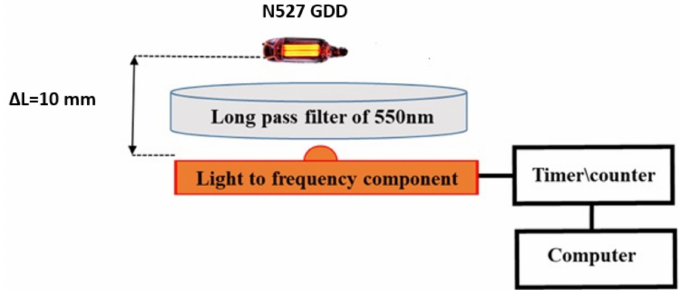
Figure 8. Experiment setup of the noise measurements.